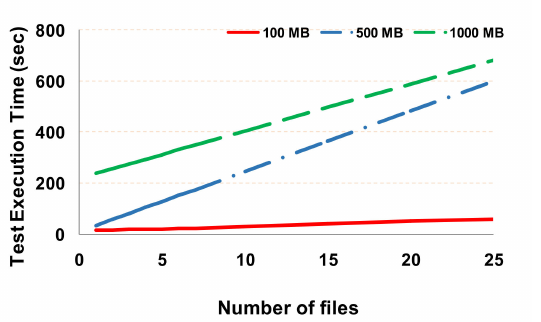
Figure 4. Execution time of testDFSIO for the different examined